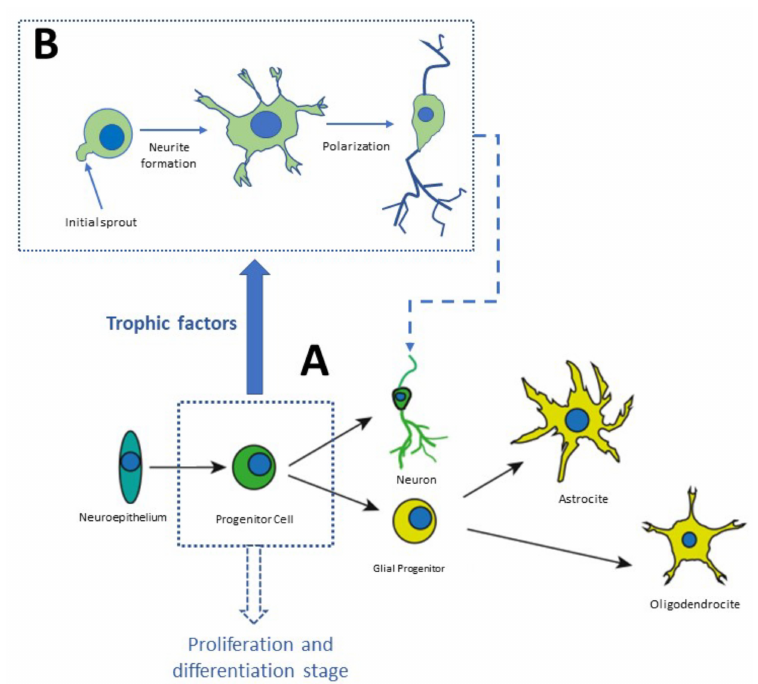
Figure 3. Stages of neurodevelopment in vitro. Stem cells derived from the neuronal niches located at specific regions in the brain or in the olfactory neuroepithelium can be plated in Petri dishes. In culture, they proliferate and amplify the population of progenitor cells which differentiate into neurons or glial cells, as shown in panel ( A ). Panel ( B ) shows distinct phases of differentiation